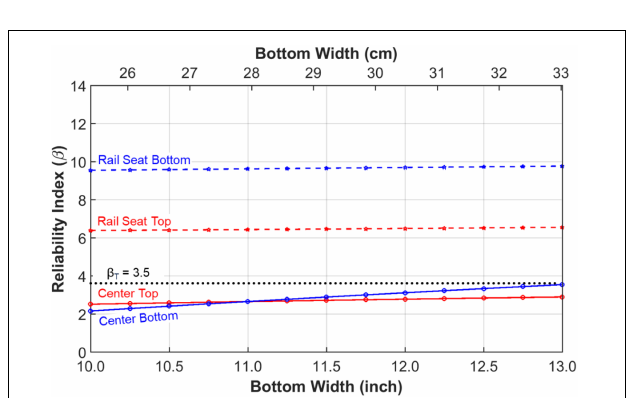
FIGURE 9 | HAL freight center bending moment structural reliability indices ( β ) as a function of bottom width, while holding other parameters constant.